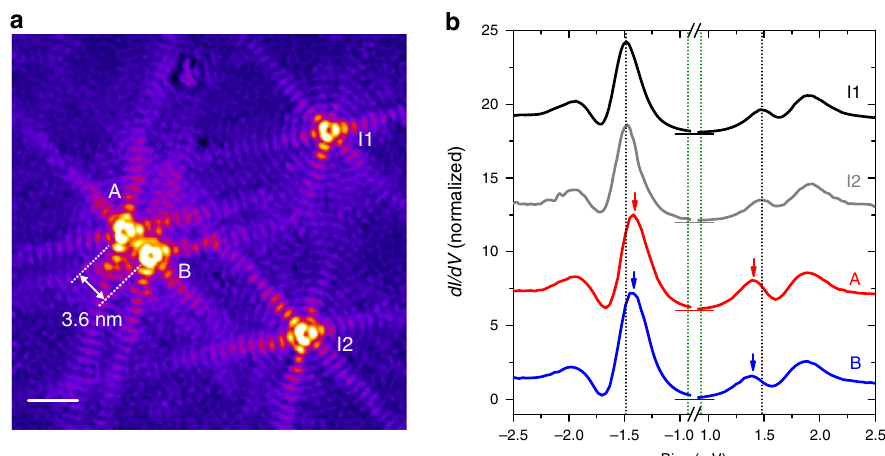
Fig. 4 Long-range coupling between YSR impurities on La(0001). a Differential tunneling conductance map showing spatial modulations of the magnetic bound states around four YSR1 impurities. Two impurities (A and B) are separated by a distance of 3.6 nm, comparable to 10 atomic lattice constants on the La(0001) surface, while the other two (I1 and I2) are spatially isolated. I T = 1.0 nA, V S = 1.2 mV, T = 1.67 K. Scale bar: 5.0 nm. b Tunneling spectra obtained at the centers of the four magnetic impurities. Black dotted lines denote the energies of ±| Δ T + E YSR | for the isolated YSR1 impurities (I1 and I2) with E YSR = 0.56meV. The edge of the superconducting gap ( Δ T = 0.93 meV) of the La-coated tip is depicted by green dotted lines. Red and blue arrows indicate the peak positions at ±| Δ T + E YSR | for the interacting impurities A and B with E YSR = 0.47± 0.01